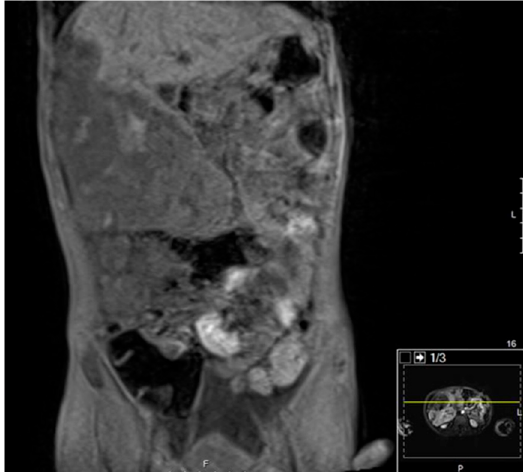
Figure 5. CT Imaging of Hepatoblastoma. There is a lobulated heterogeneous mass involving the fifth and sixth segments of the right lobe, which also contains well-defined rounded hypoattenuating areas. No calcification can be seen. The mass extends inferiorly from the right lobe of the liver as well as extending lateral and anterior to the liver at its superior aspect. The mass measures approximately 21.7 cm in greatest sagittal dimension and 10.6 cm in greatest transverse dimension and 10.7 cm in greatest AP dimension. Superiorly, the mass appears to displace the anterolateral aspect of the liver posterior and medially and inferiorly, the mass displaces bowel posteriorly and medially. Table 2. Histopathology of